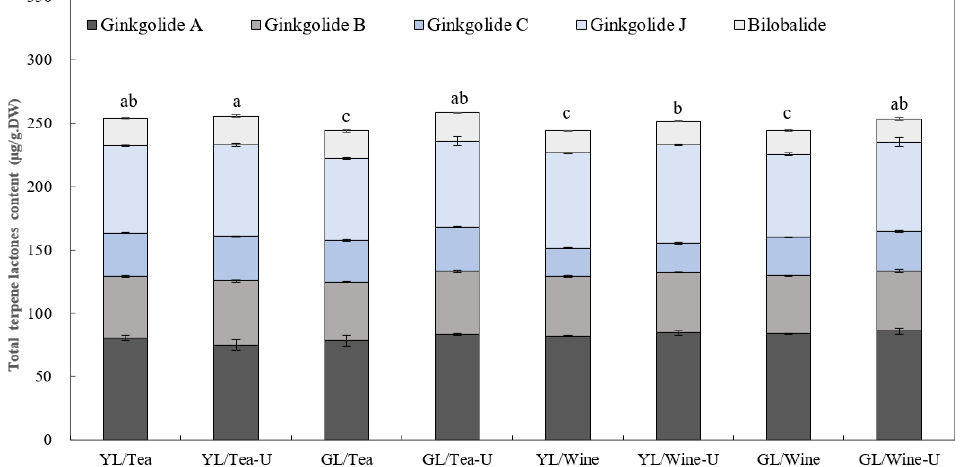
Figure 5. Analyses of the terpene trilactones (TTLs) in the ginkgo tea and wine. TTLs were quanti- fied and calculated with the specific standard curve plotted by UHPLC-QTOF-MS with authentic substrates. Data are presented as mean ± SD. Different letters represent significantly different values with an alpha value at 0.05, n = 3. Table 3. Measurement of the total terpene trilactones (TTLs) concentrations in GBE drinks.